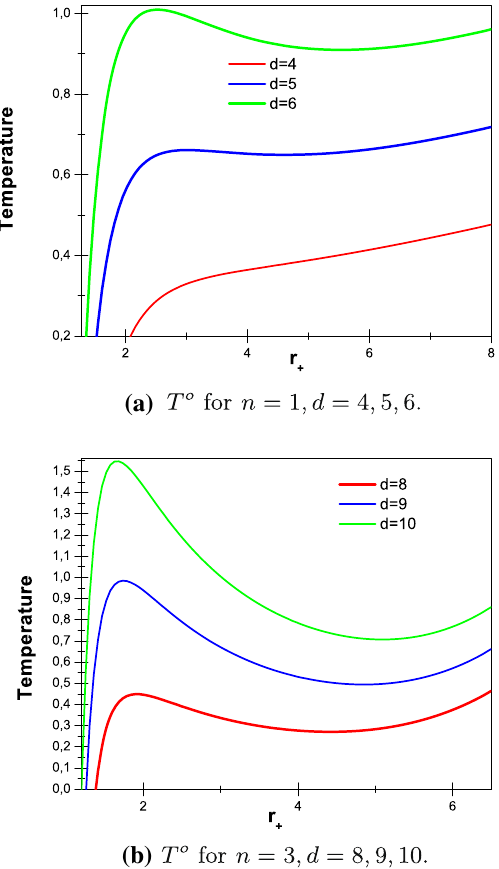
Fig. 3 T o . a Represents both families of solutions, and b represents to the first family of solutions, both with toy values of Q = 1 and l =